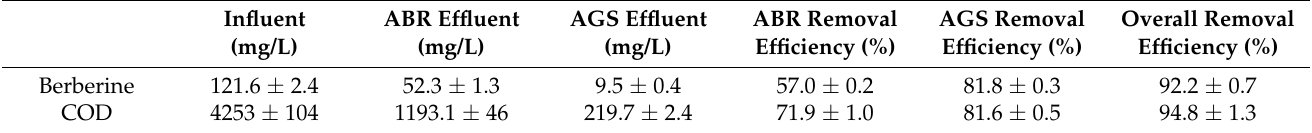
Table 1. The results of the berberine wastewater treatment in the hybrid ABR–AGS